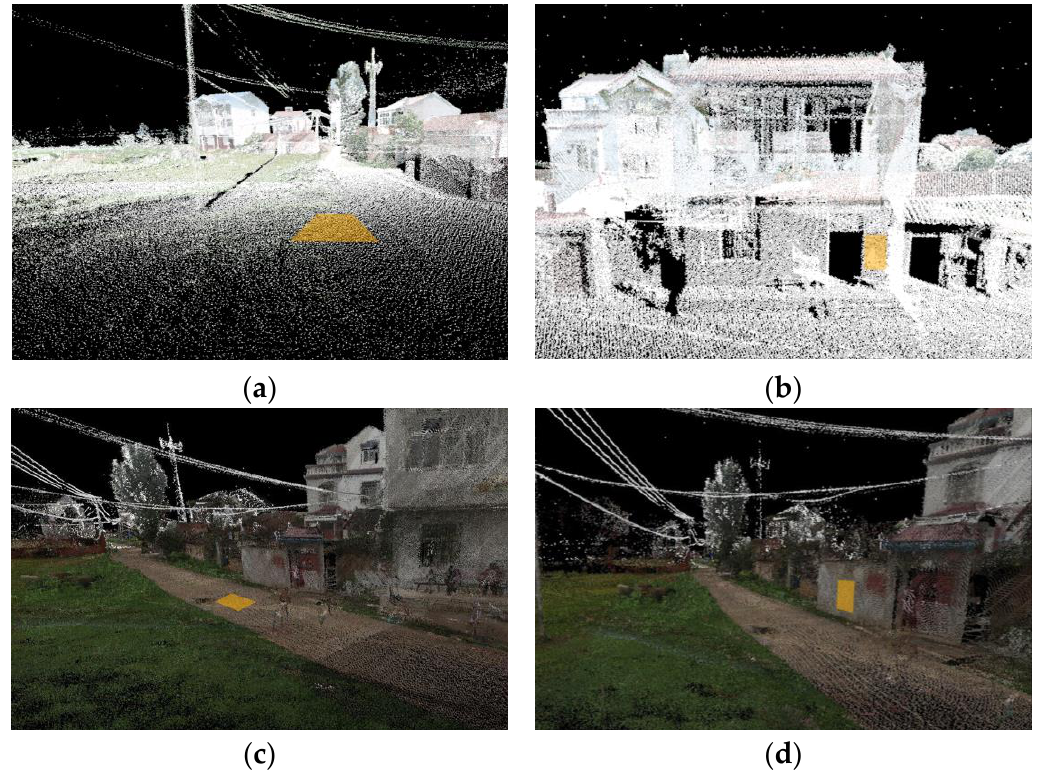
Figure 5. Precision of the collected MTLS point clouds: ( a ) elevation; ( b ) planimetry for stop-and-go SSW system; ( c ) elevation; ( d ) planimetry for electro-tricycle SSW system.